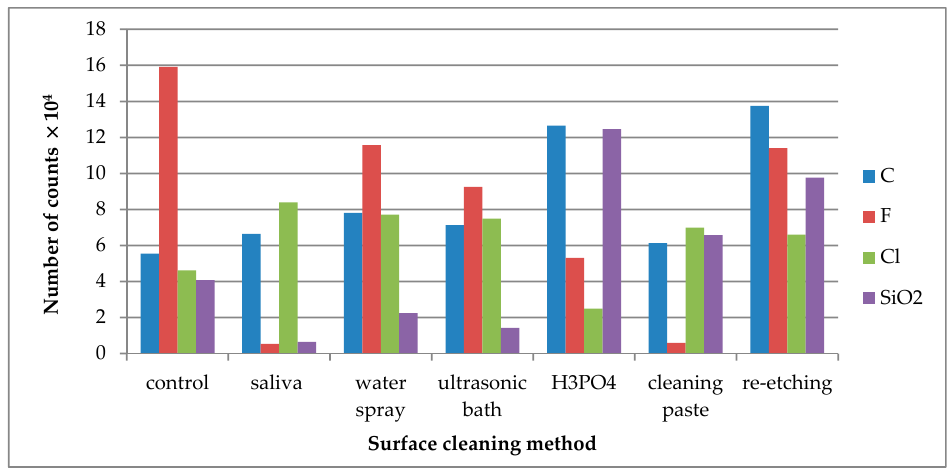
Figure 3. Number of counts of negative ions emitted from the surface of leucite glass ceramic (LGC) after various surface cleaning methods.